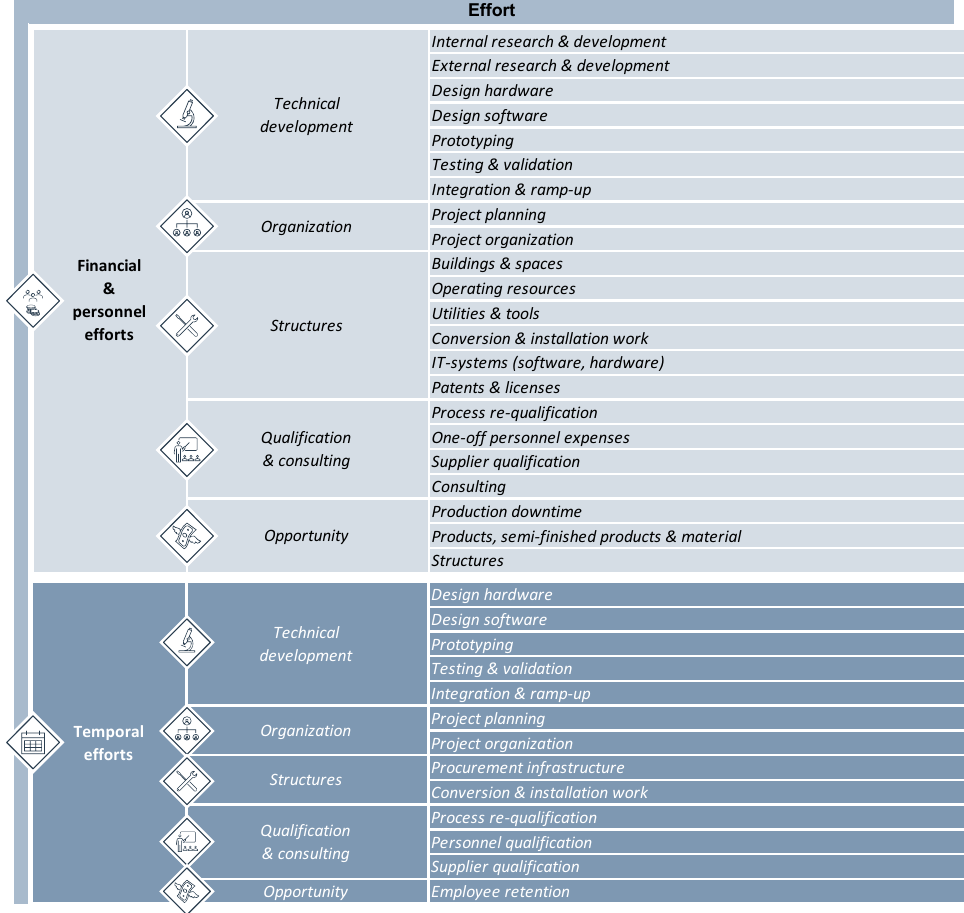
Figure 5. Relevant criteria to assess the efforts of innovation projects in manufacturing.